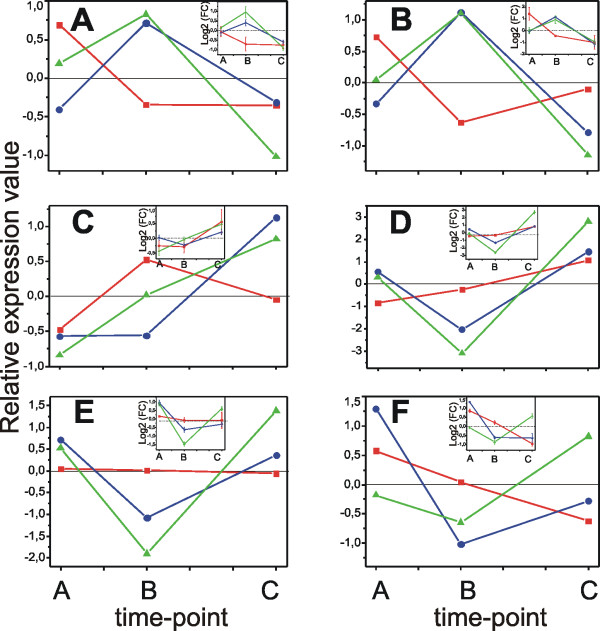
Real time RT-PCR validation of the expression profiles of six genes highly influenced by the season. A: 1615199_at, Cryptochrome 1; B: 1616872_at, Pseudo response regulator 9; C: 1614764_at, VvHT2, hexose transporter 2; D: 1606663_at, VvChs3, chalcone synthase isoform 3; E: 1607732_at, VvChs2: chalcone synthase isoform 2; F: 1620424_at, VvChi2, chalcone isomerase isofom 2. 2003 profiles are represented in red, 2005 in blue and 2006 in green. Relative expression data of the array hybridization experiments were centered on the average of the log2 values of each season. Expression profiles measured by RT-PCR experiments (insets) were first centered on the mean Ct value calculated on the three seasons for each gene and then log2 transformed. RT-PCR data are reported as means ± SE of three technical replicates.